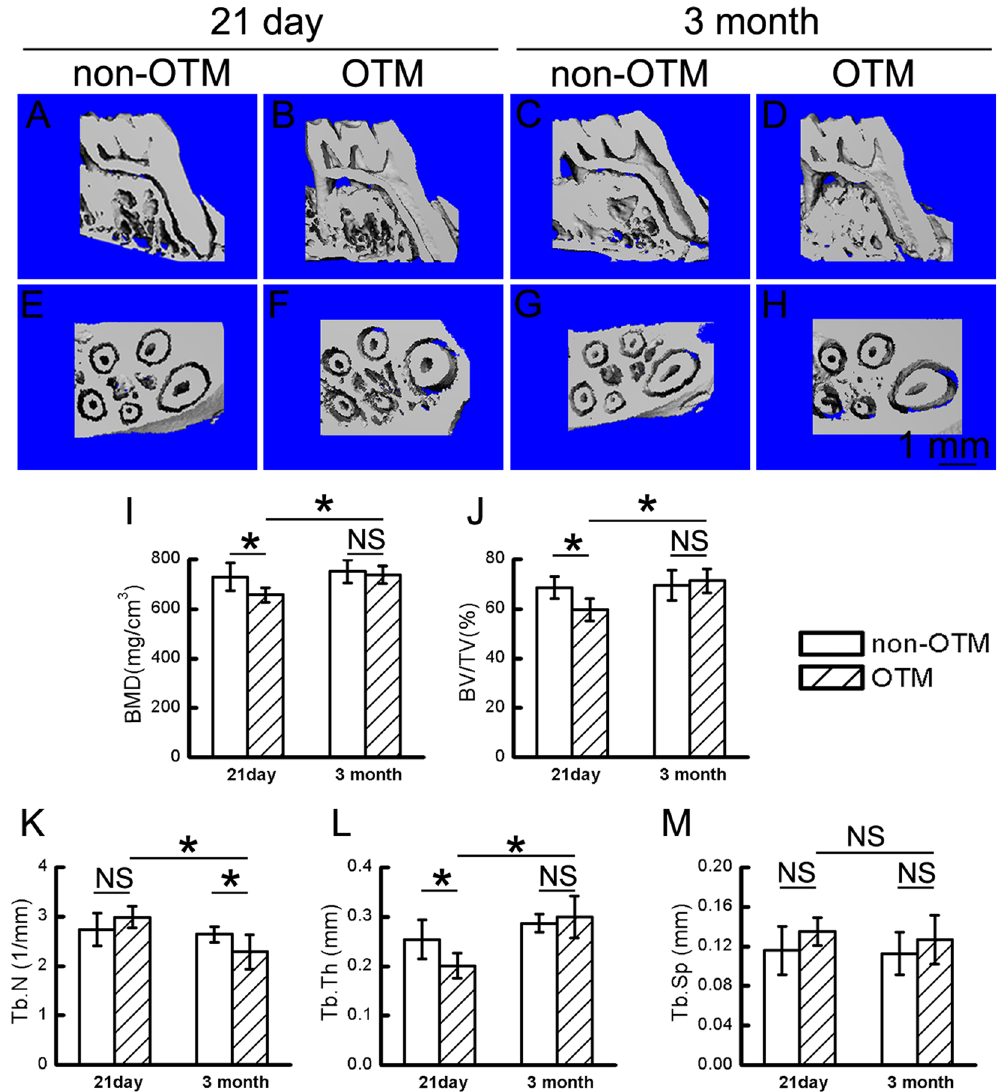
Figure 4. Alveolar bone recovery after OTM in OVX rats. ( A – H ) Three-dimensional reconstruction of alveolar bone in the Non-OTM and OTM groups on day 21 of OTM (21 day) and 3 months after OTM (3 month) in OVX rats. ( I – M ) Analysis of microstructural parameters of alveolar bone during and after OTM in OVX rats. BMD, bone mineral density; BV/TV, bone volume fraction; Tb.Th., trabecular thickness; Tb.N., trabecular number; Tb.Sp., trabecular separation. Data represent means ± S.D. * P < 0.05, NS P ≥ 0.05, n =